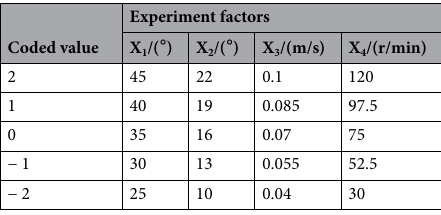
Table 3. Factors and levels of virtual experiment.